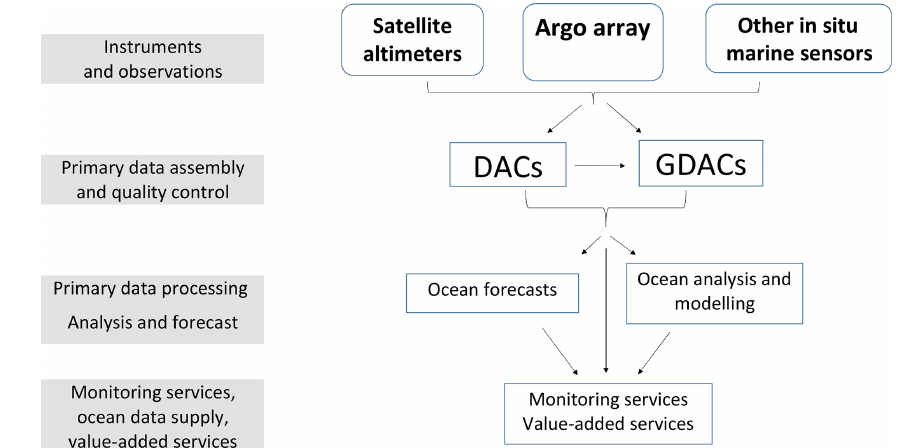
Figure 5. Simplified description of the ocean data supply chain including the Argo array: observational data are provided to the Data Assem- bly Centres (DACs) and Global Data Assembly Centres (GDACs) and then to scientific users for processing and modelling. Observational and processed data are used for monitoring services. Table 1. Argo programme costs for the Atlantic Ocean observing network. Estimated annual costs (time period of analysis: 2012–2016) Core Argo (T&S) BGC-Argo Deep Argo a Average yearly number of floats deployed b 229 Average unit cost (EUR) 15890 85000 30000 Additional unit costs per year Testing and calibration (EUR) 300 300 Logistics (EUR)